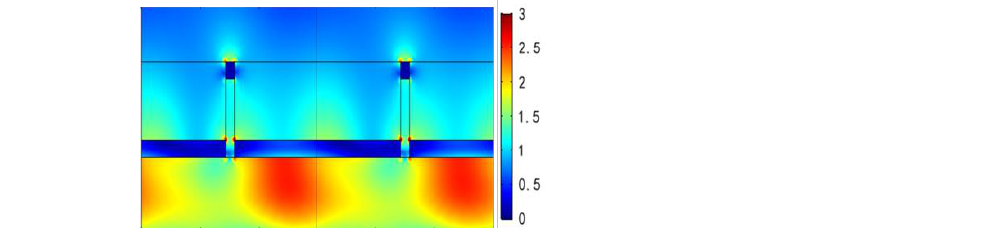
Figure 9. Electric field distribution of the little dip ( λ = 792 nm, n = 1.0) between the first dip and the second dip at θ = 10° for TM polarized incidence from the bottom of single layer metal film grating.